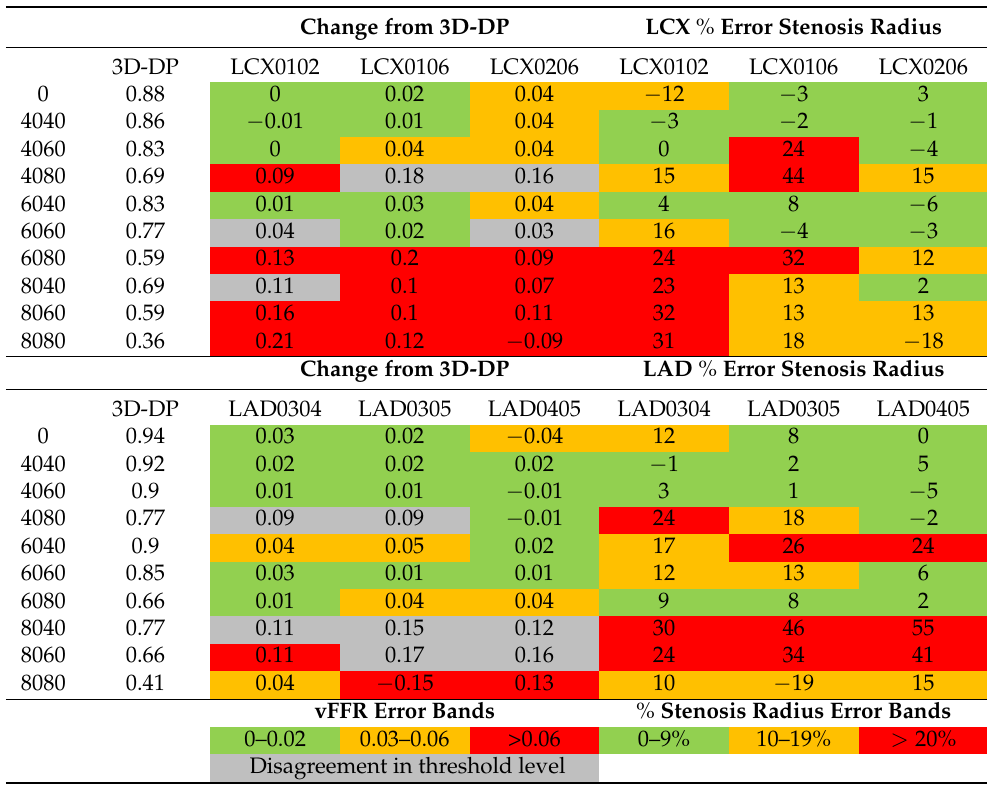
Table 6. Summary of absolute FFR error and relative stenosis radius error for all